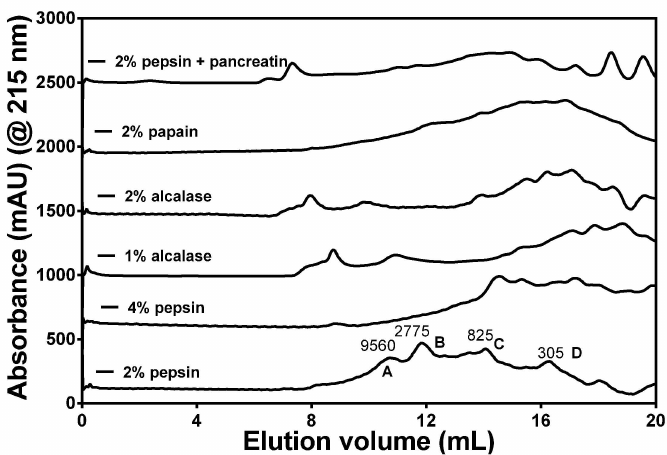
Figure 2. Gel-permeation chromatograms of different enzymatic hemp seed protein hydrolysates at different concentrations after passage through a Superdex Peptide 10/300 GL column.